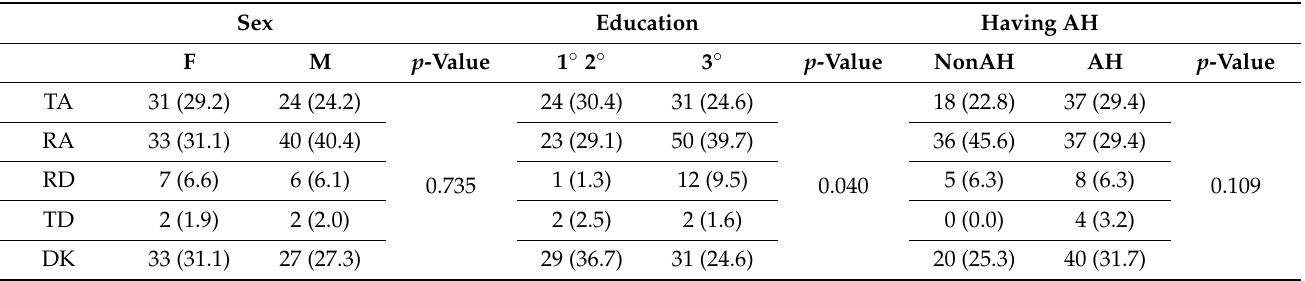
Table 3. Presence of hypertension in parents as a factor that increases the incidence of hypertension by gender, education, and having hypertension (N = 205).